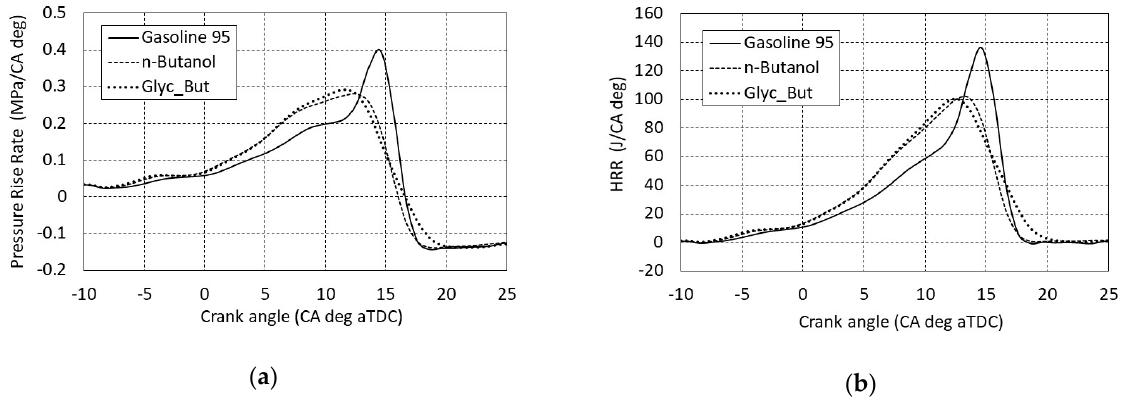
Figure 3. ( a ) Pressure rise rate, ( b ) HRR vs. crank angle for the tested fuels at spark timing of − 10 CA deg aTDC.